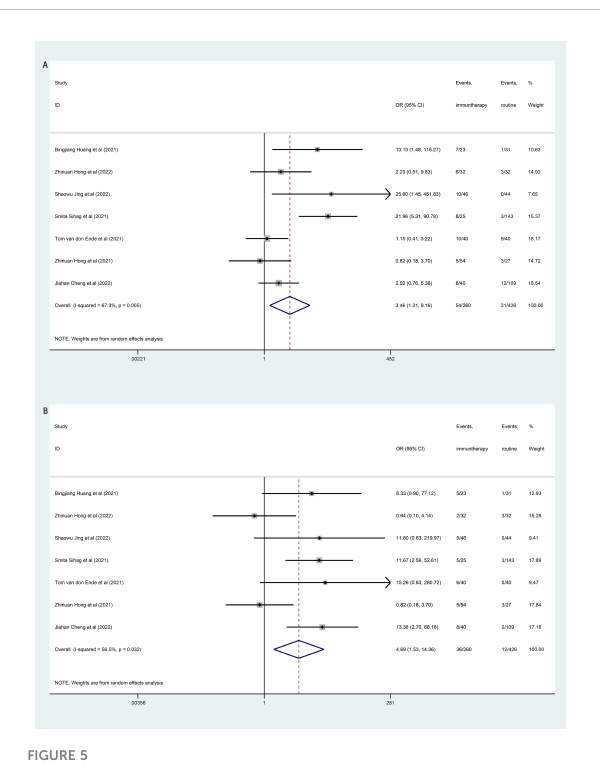
FIGURE 5 Forest plot of treatment related adverse events (TRAEs). (A) : Forest Plot of pneumonitis/pneumonia; (B) : Forest Plot of thyroid